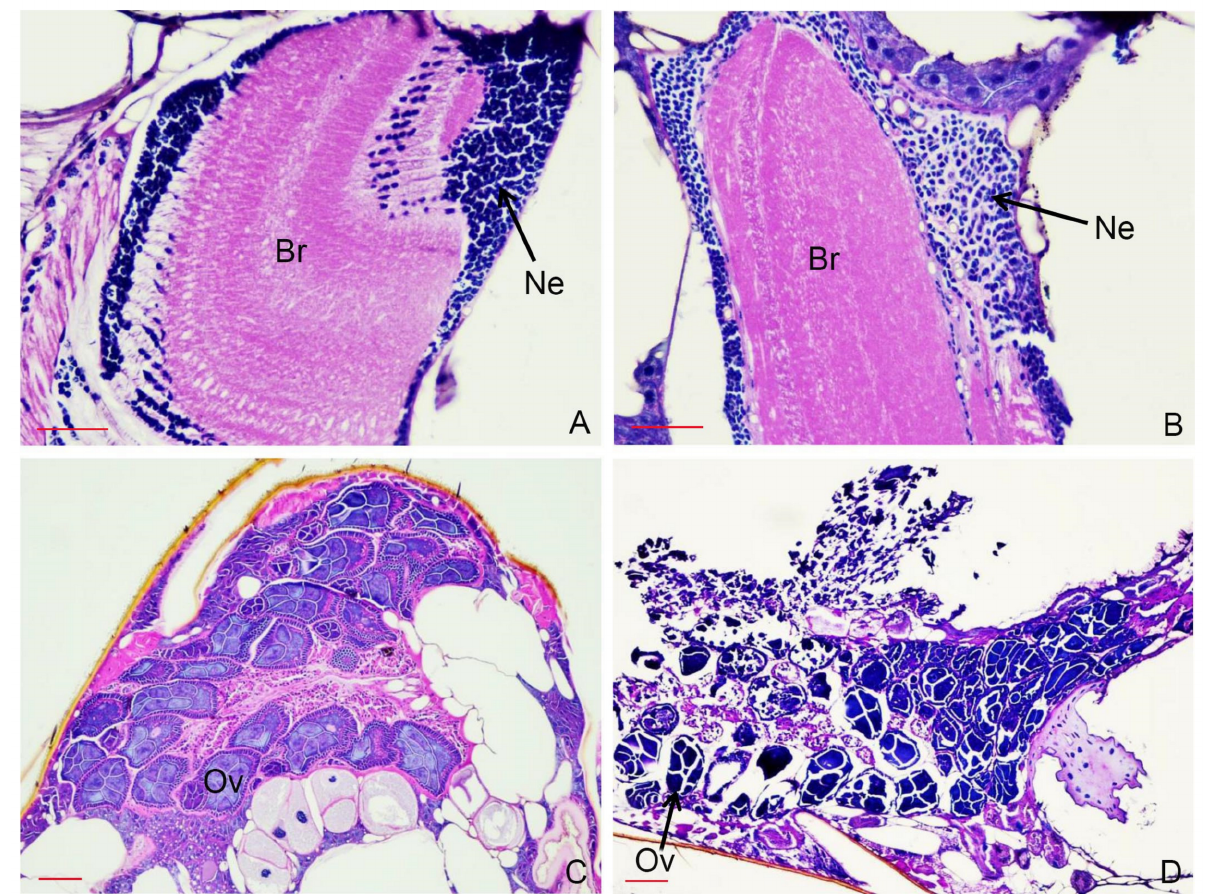
Figure 3. Histopathological changes in the brain ( A , B ) and ovaries ( C , D ) of Tabanus megalops : control ( A , C ) and at 24 h after treatment with Plectranthus amboinicus essential oil (131.41 µ g/fly) showing interstitial neuronal edema of the brain ( B ) and ovarian necrosis ( D ). Light microscope image of a paraffin section stained with hematoxylin and eosin. ( A , B ) Bar, 50 µ m. ( C , D ) Bar, 100 µ m. Br: brain; Ne: neurons; Ov: